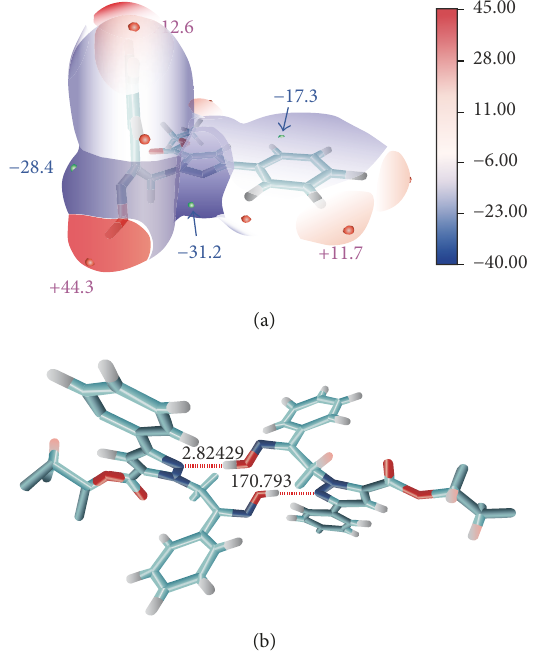
Figure 7: (a) ESP mapped molecular van der Waals surface of Z isomer: the unit is in kcal/mol. Maxima of ESP and surface local minima are marked as orange and green spheres, respectively. The values of some prominent surface extremes are labeled on the graph, and the italic font labels global maximum and minimum. (b) An illustration of intermolecular H-bond in the crystal of Z isomer: only a pair of dimers is shown for clarity, and the red-dashed lines correspond to the